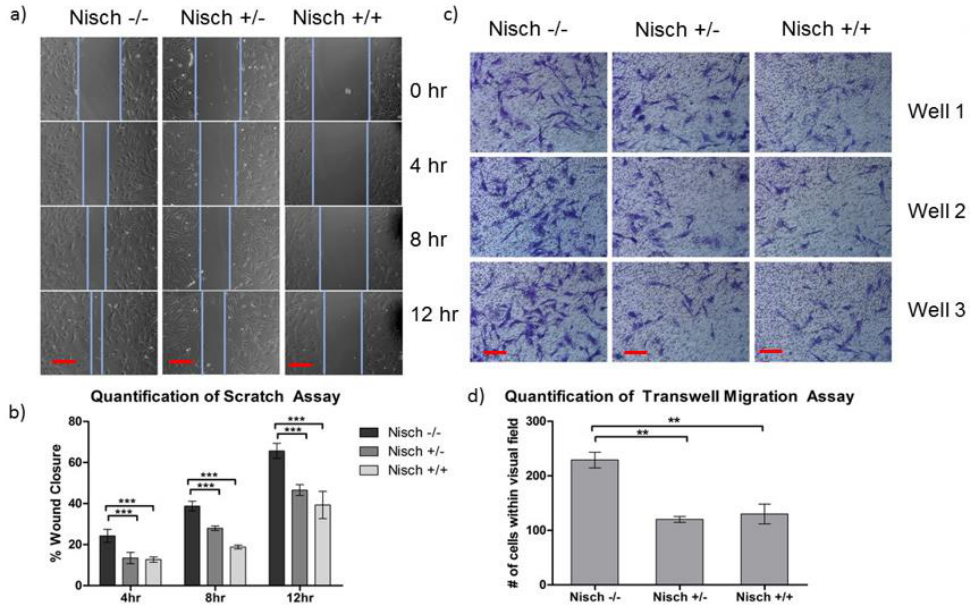
Figure 3. Nisch − / − MEF cells demonstrate increased migration: ( a , b ) MEF cells were seeded in triplicate for each genotype and allowed to adhere to the plate for 16 h. A scratch was performed with the tip of a 200 µ L pipette tip, and the cells were photographed at time points of 0, 4, 8, and 12 h. Nisch − / − MEF cells demonstrated closure of the scratch at a faster rate than Nisch +/ − and Nisch +/+ cells; ( c , d ) MEF cells were seeded in transwell migration inserts in DMEM supplemented with 0.5% FBS. The bottom chamber was filled with DMEM supplemented with 10% FBS, acting as a chemoattractant for cells to travel through the pores. Nisch − / − MEF cells had more cells migrate across the pores in the 16 h time period than Nisch +/ − and Nisch +/+ MEF cells. Statistically significant values of ** p < 0.01, and *** p < 0001 were assigned using two-way t -test analysis between the three genotypes. Experiments were performed in triplicate and repeated two times. Scale bar = 100 µ